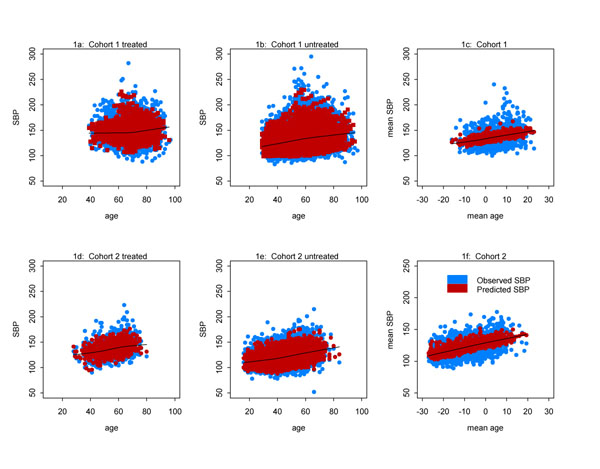
Comparisons of observed SBP and predicted values for the selected sample A, B, D, E are based on the multilevel model. C and F are based on the sample-wide regression for the selected sample [2].